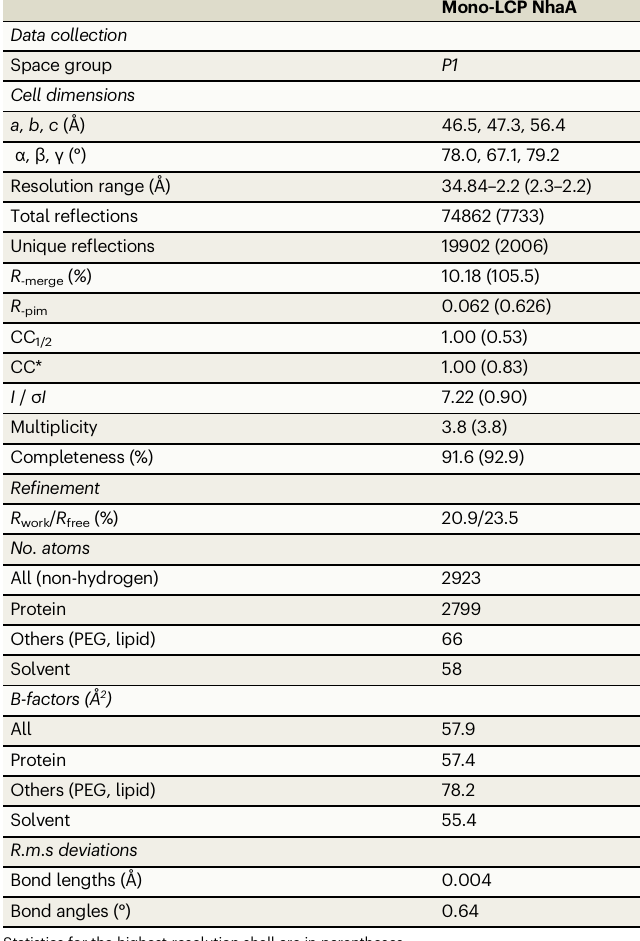
Table 1 | Data collection, phasing and re fi nement